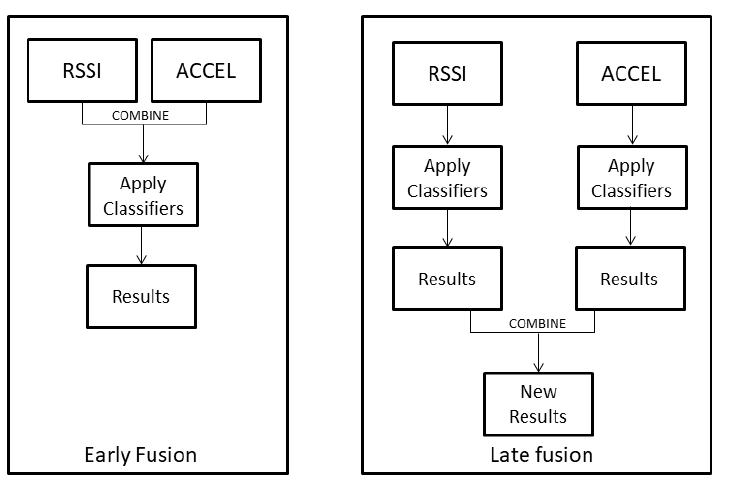
Figure 1. Application process in early ( left ) and late ( right )